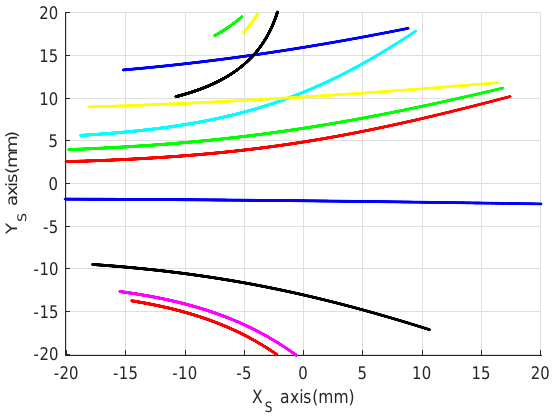
Figure 6. imaging track of observable landmarks.